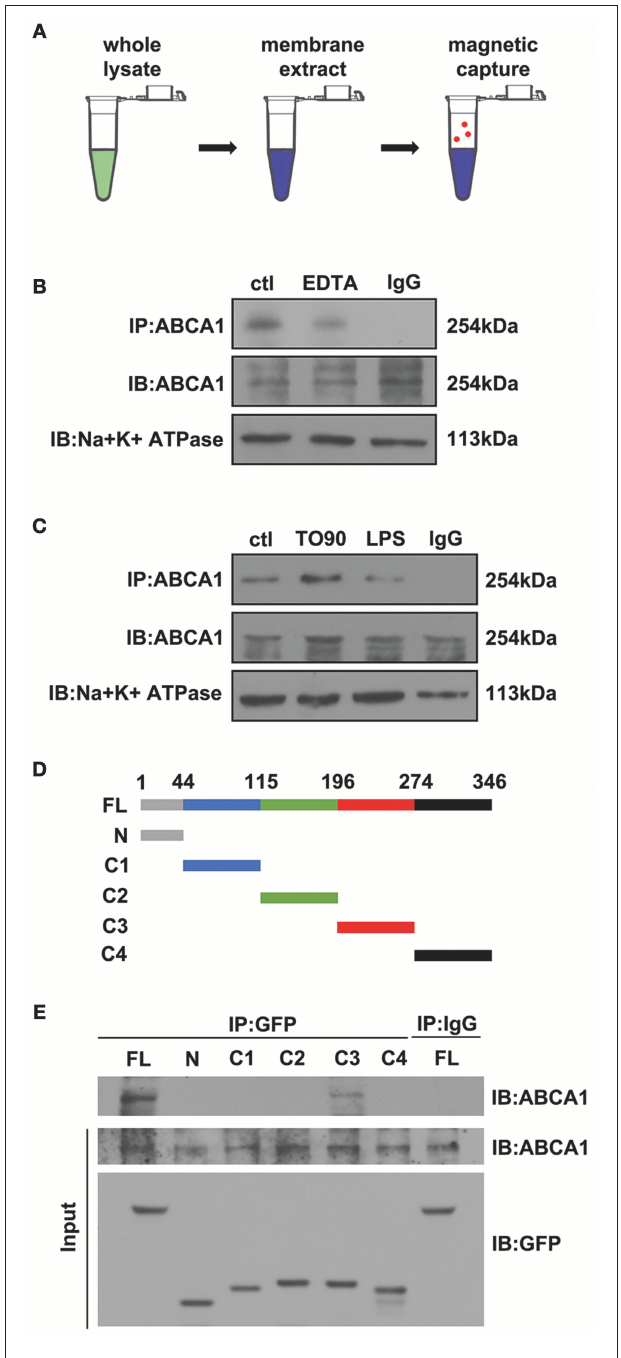
FIGURE 4 | The interaction between ABCA1 and ANXA1. (A) Schematic diagram of Co-IP between ABCA1 and ANXA1. (B) Western blotting analysis demonstrating that EDTA decreases the interaction between ABCA1 and ANXA1. (C) A western blotting analysis indicates that LPS reduces the interaction between ABCA1 and ANXA1, and this effect is inhibited by TO901317. (D) Schematic diagram of full-length and fragment ANXA1 plasmids. (E) Co-IP results demonstrate that the binding between ANXA1 and ABCA1 involves the C3 domain of ANXA1 (amino acids 196 to 274).